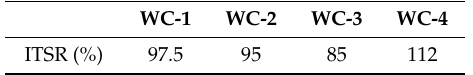
Table 13. Value of indirect tensile strength ratio for particular